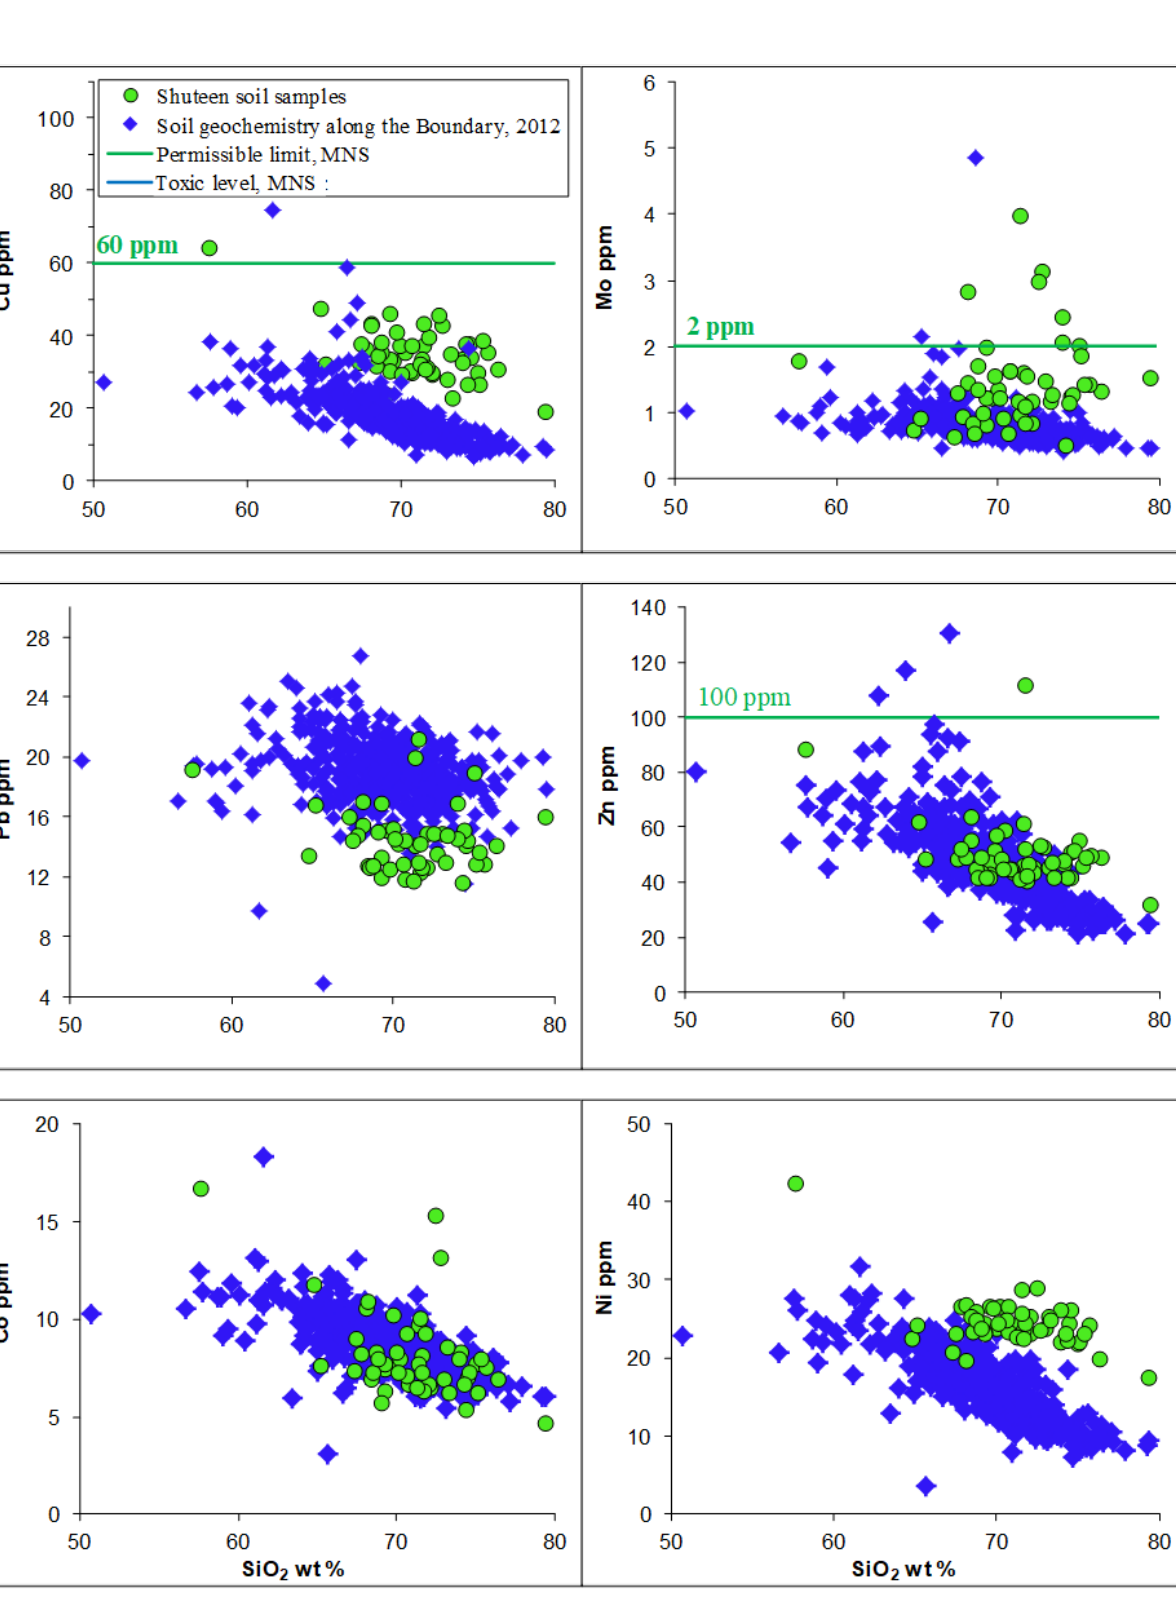
diagram for the Shuteen 2